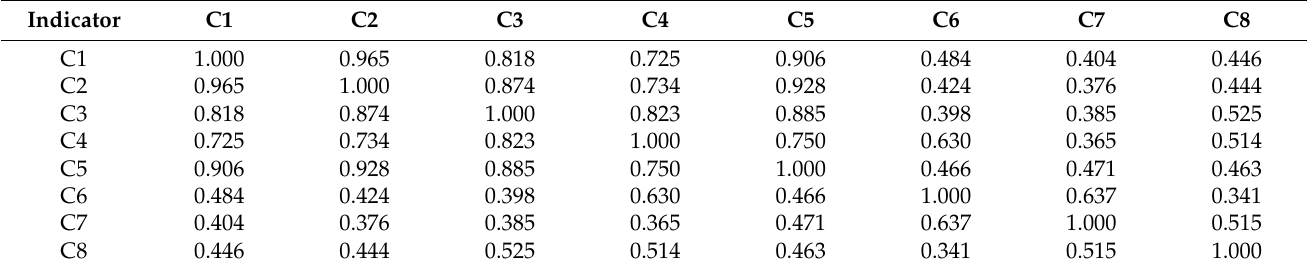
Table A5. The distance correlation matrix.